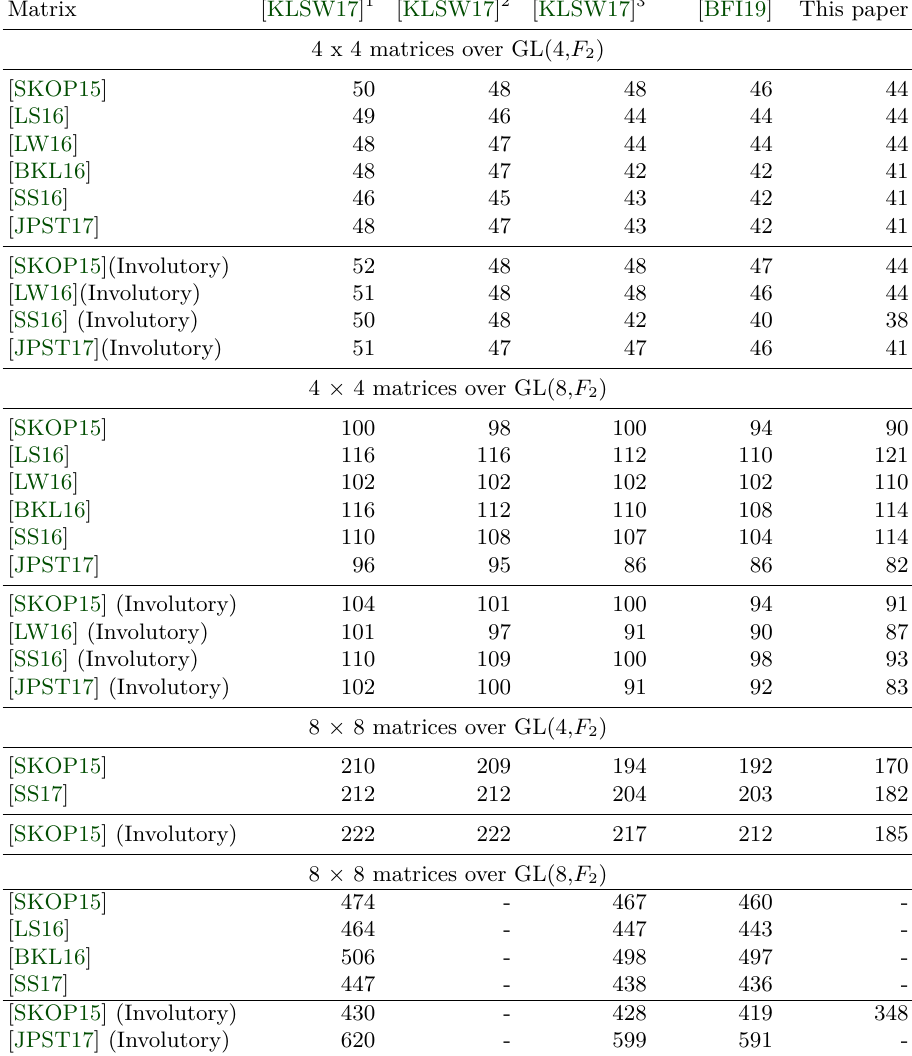
Table 2: Implementation cost of newly designed matrices under different optimization